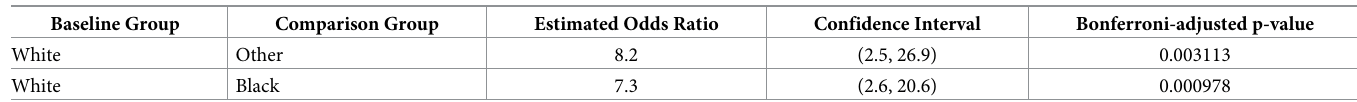
Table 5. Tests of differences by race, King County, Washington anti-SARS-CoV-2 seroprevalence survey, August 2020. Baseline